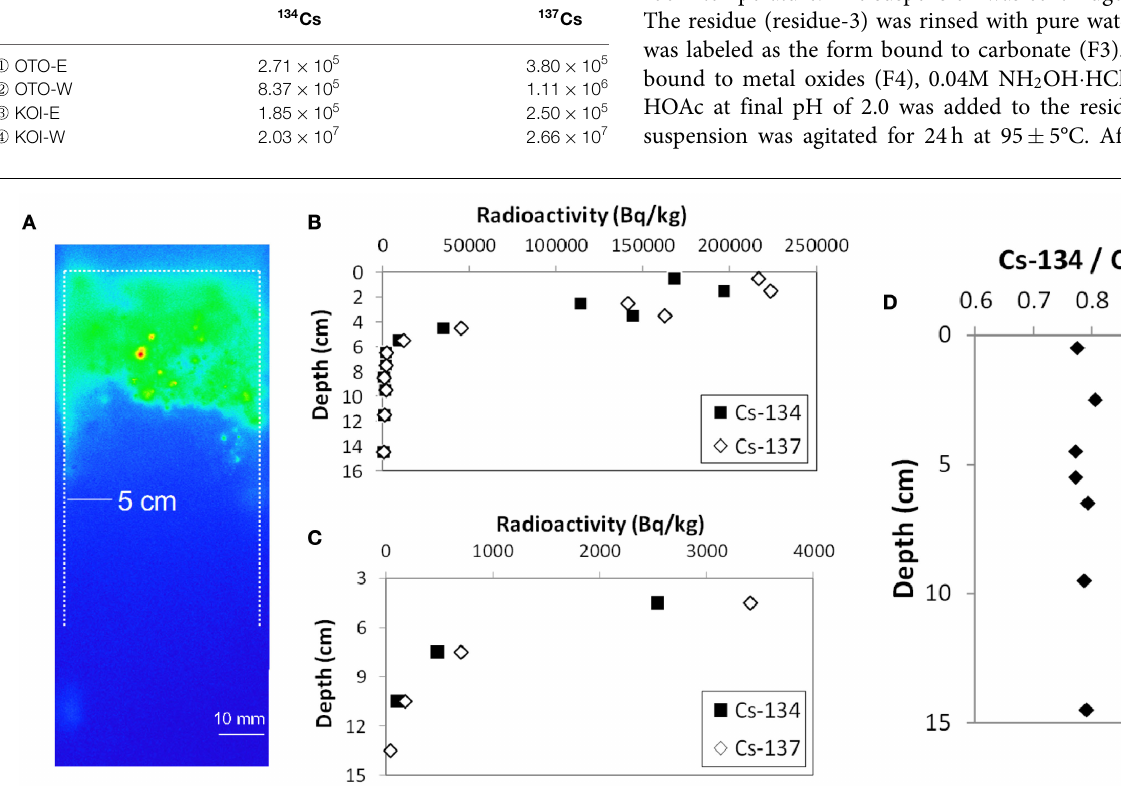
FIGURE 2 | Vertical distribution of Cs in the KOI-E core sample . (A) Autoradigraphy image of cross section of the core sample. (B) 134 Cs and 137 Cs radioactivity in the soil core sample. The surface of the core along the plastic liner tube was carefully decontaminated. (C) The enlarged figure of (B) . (D) The radioactivity ratio of 134 Cs and 137 Cs for the vertical